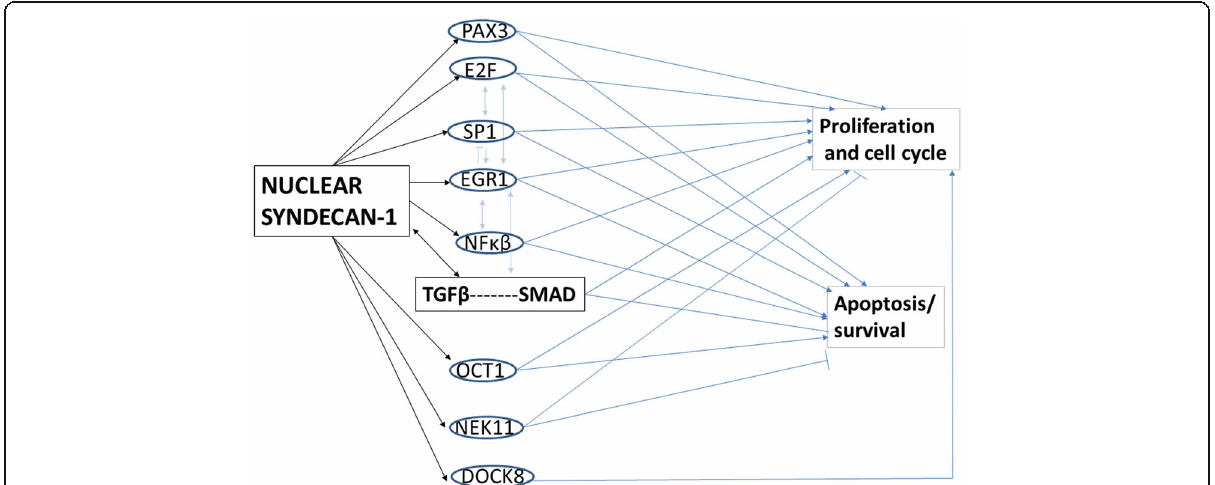
Fig. 9 Regulatory network elicited by nuclear translocation of syndecan-1 leading to inhibition of proliferation and survival. Data are based on differentially expressed genes obtained by microarray and transcription factor array on fibrosarcoma cells with preserved and impaired nuclear translocation of syndecan-1. Nuclear syndecan-1 activates several transcription factors (ovals) and induces immediate early genes. Transcription factors activate (arrows) or inhibit (bars) their targets, and in addition, they trigger the TGF- β pathway (rectangle). In turn, TGF- β can also induce EGR-1 and other transcription factors, which can provide a feedback loop. The arrows in blue represent the current knowledge about the role of target genes in governing different processes. The functional outcome of nuclear syndecan-1 signaling is the measured inhibition of proliferation and cell